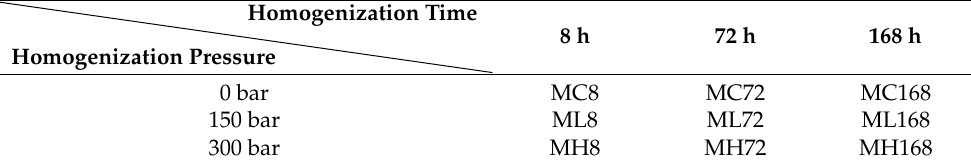
Table 1. Different homogenization pressures and storage time of pasteurized milk